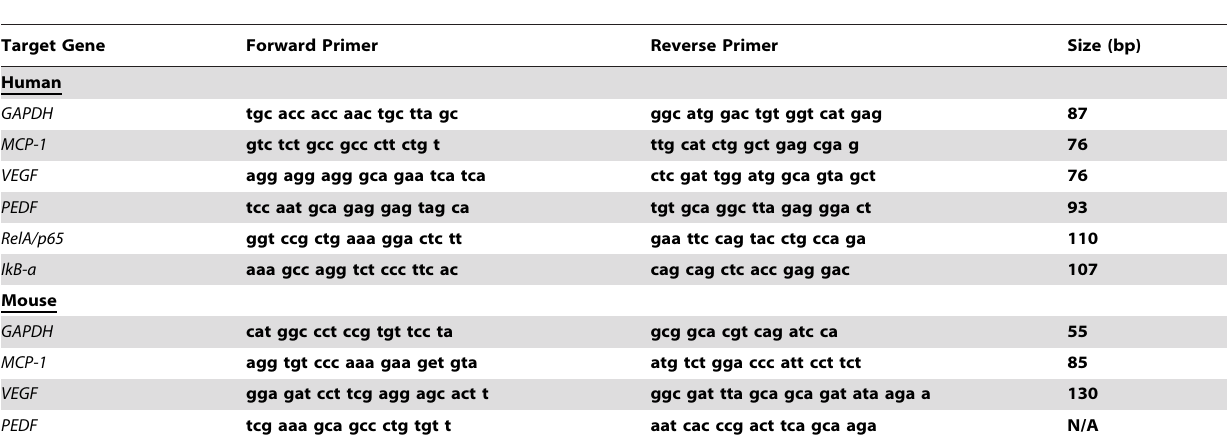
Table 2. Real-time PCR Primers.